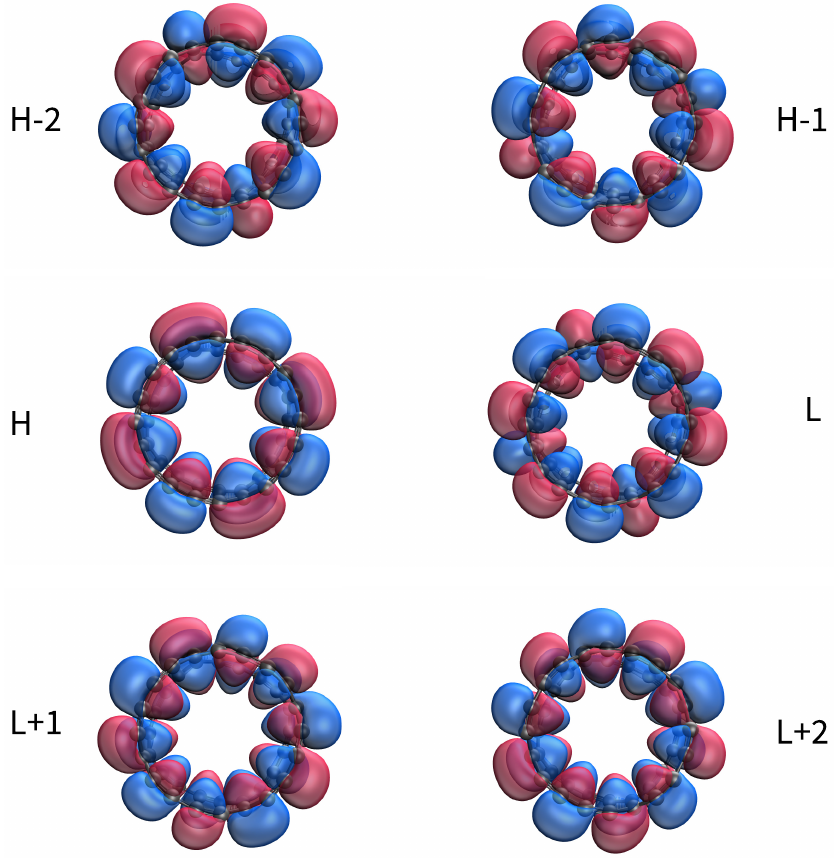
Figure 8. Visualization of active TAO-orbitals, such as H − 2 (1.951), H − 1 (1.950), H (1.935), L (0.117), L + 1 (0.032), and L + 2 (0.032), of ground-state C-Belt[4] at an isovalue of 0.02 e/Å 3 , computed using spin-restricted TAO-LDA. Numbers in parentheses show the